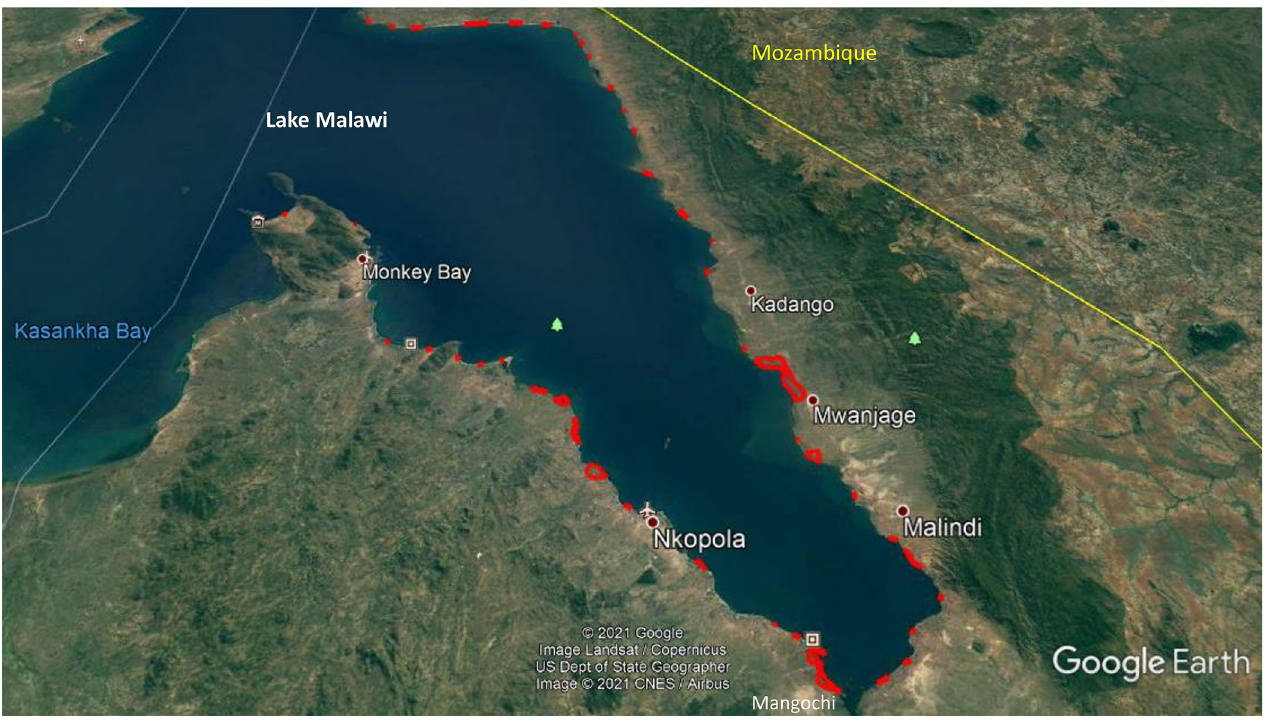
Fig 3. Map of Mangochi district in Malawi showing study clusters. Source: Google Earth Pro with study clusters drawn by the study team.